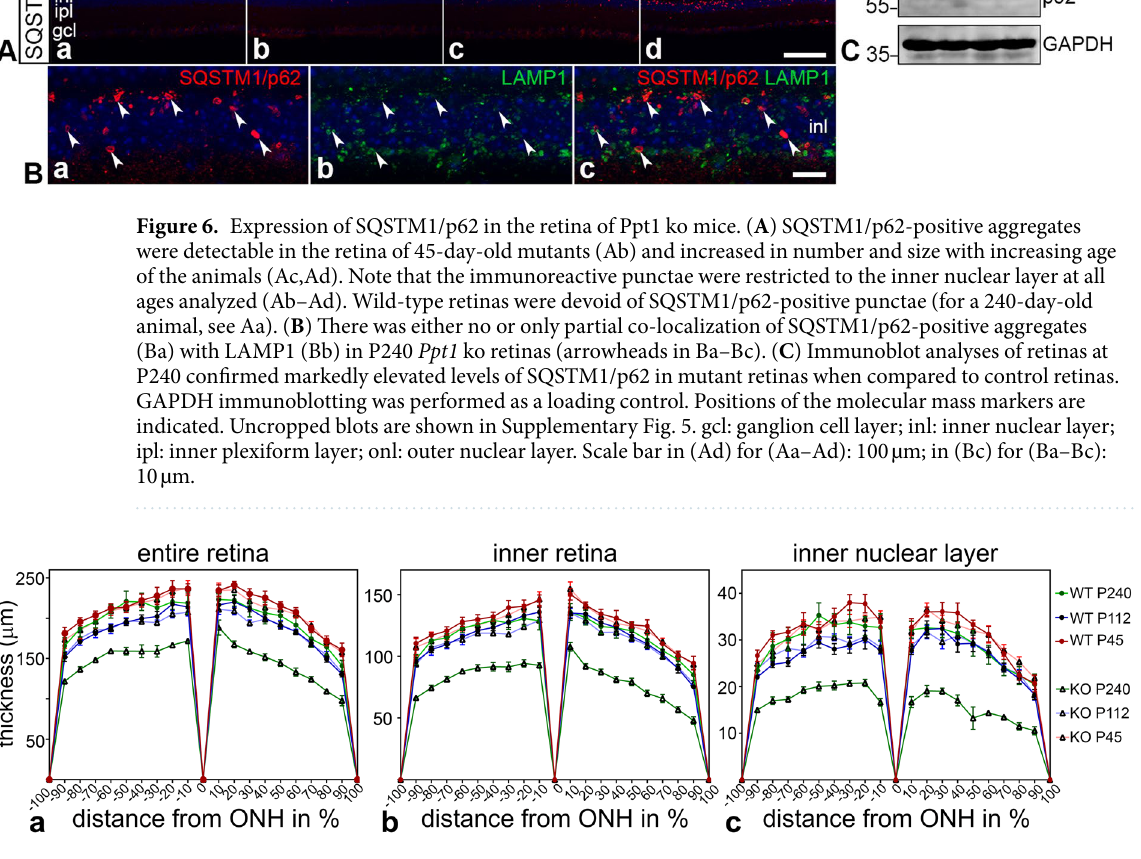
Figure 7. Thickness of the entire retina, inner retina and inner nuclear layer of Ppt1 ko and age-matched wild-type mice. The thickness of the entire retina ( a ), inner retina ( b ) and inner nuclear layer ( c ) was similar in 45- or 112-day-old Ppt1 ko and wild-type mice, but significantly reduced in P240 mutants when compared to age-matched wild-type mice (p < 0.001 for all comparisons between 240-day-old mutant and wild-type mice; three-way ANOVA followed by a Bonferroni post-hoc test). Values represent the mean ± SEM from six animals of each age and genotype. ONH: optic nerve